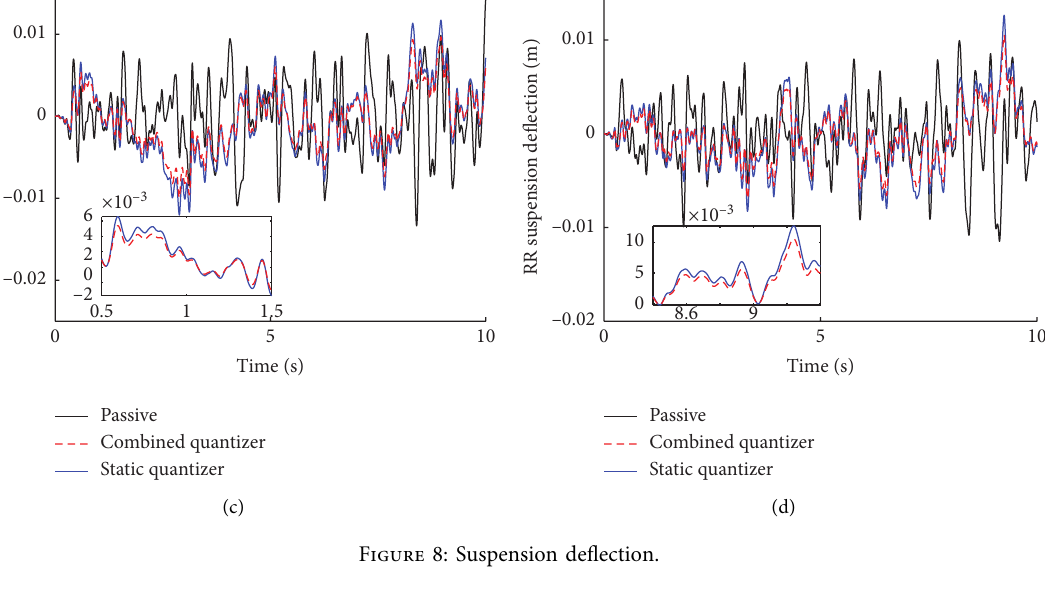
Figure 8: Suspension deflection.